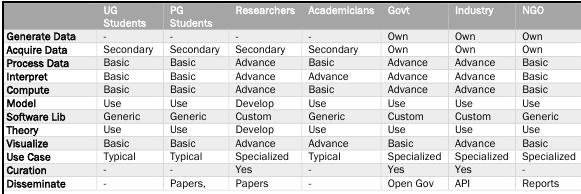
Table 2: Level of proficiency at each target group